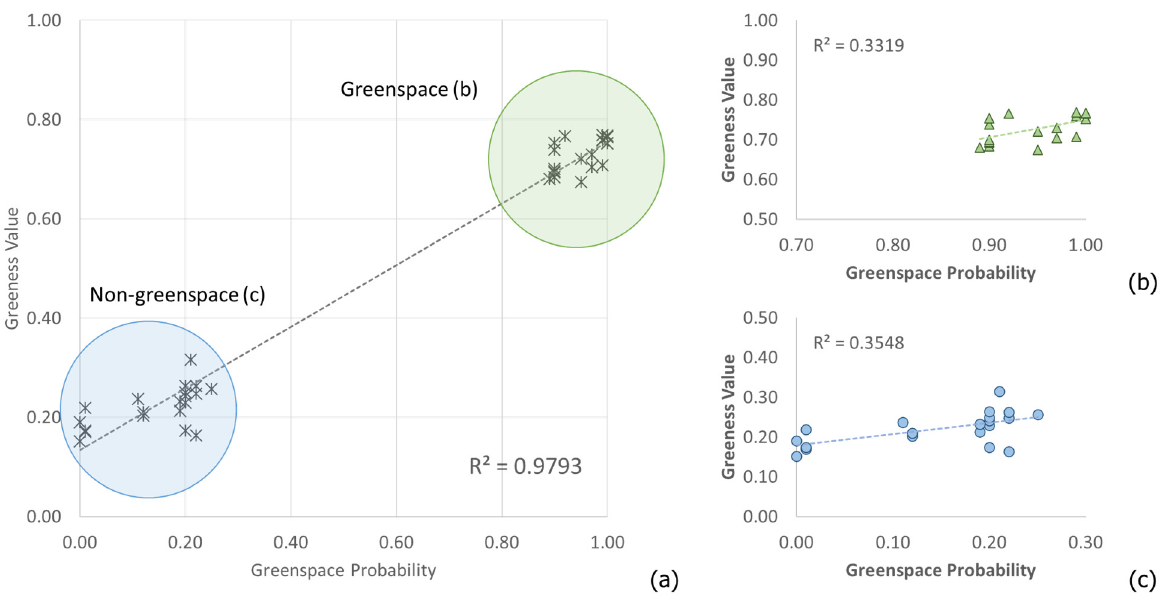
Figure 17. Scatter plots showing the correlation between DL class probability and greenness value for both classes ( a ), and only green space ( b ) and non-green space ( c ) classes.